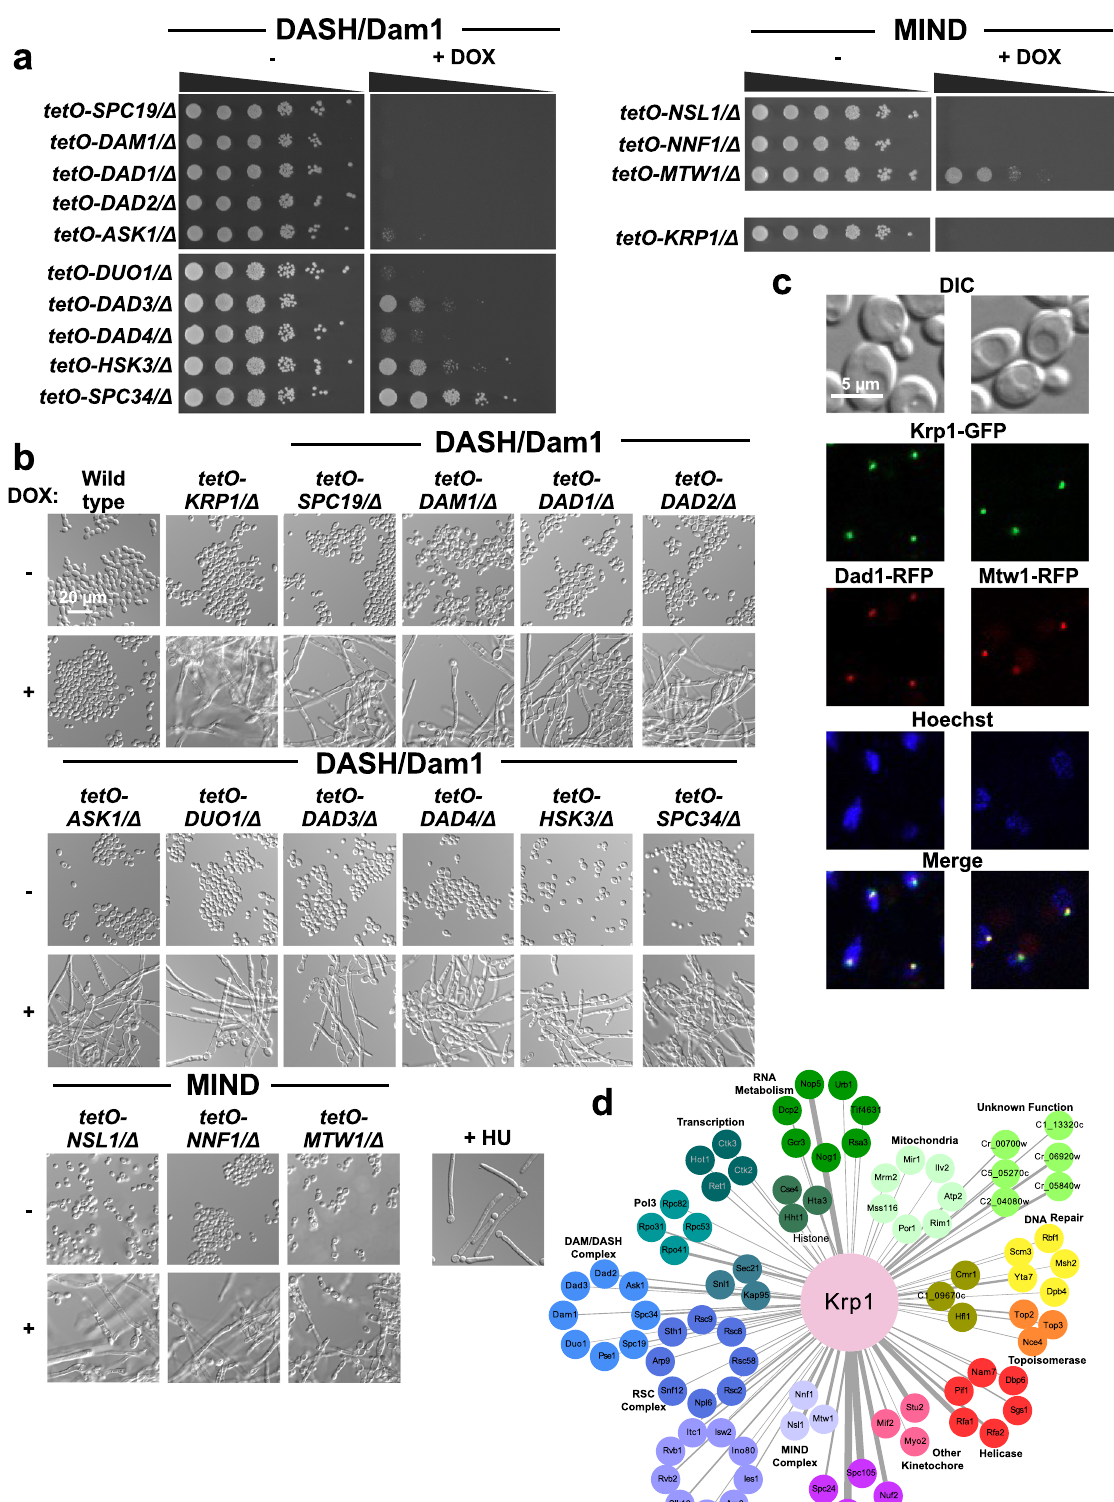
at the nuclear periphery, which co-localized with red puncta in both strain backgrounds (Fig. 3c), suggesting that Krp1 may directly or indirectly interact with Dad1 and/or Mtw1. Finally, to elucidate the Krp1 interactome in C. albicans we performed af fi nity puri fi cation of Krp1-GFP using a GFP-trap resin, followed by mass spectrometry. To distinguish signi fi